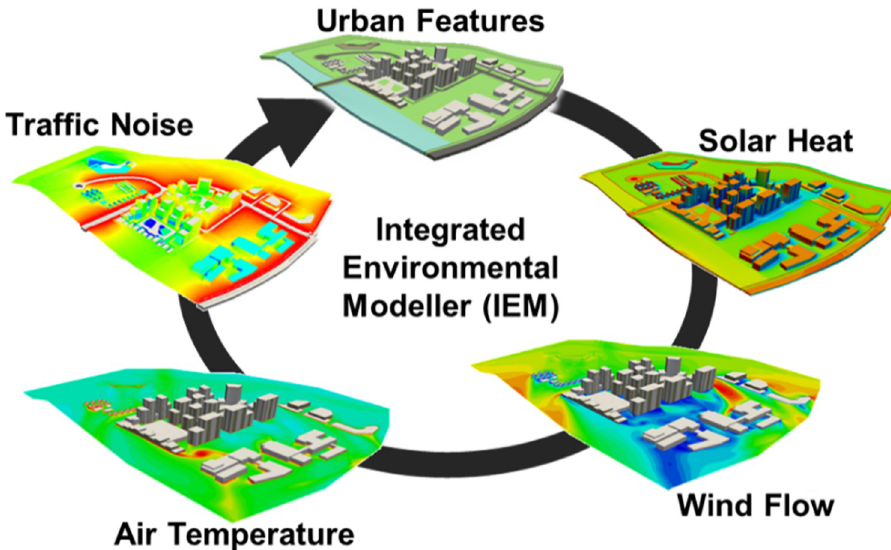
Fig 3. The workflow of coupled simulations using